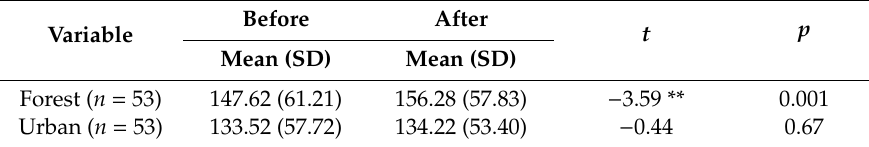
Table 5. Changes in serotonin levels before and after forest therapy.